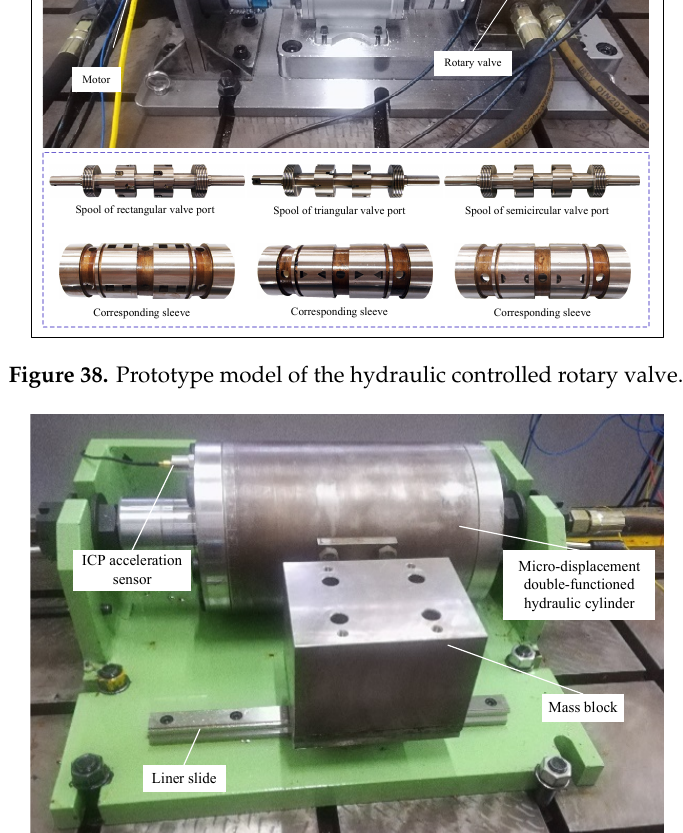
Figure 39. Electro-hydraulic vibration exciter. Table 2. The specifications of the experimental setup.